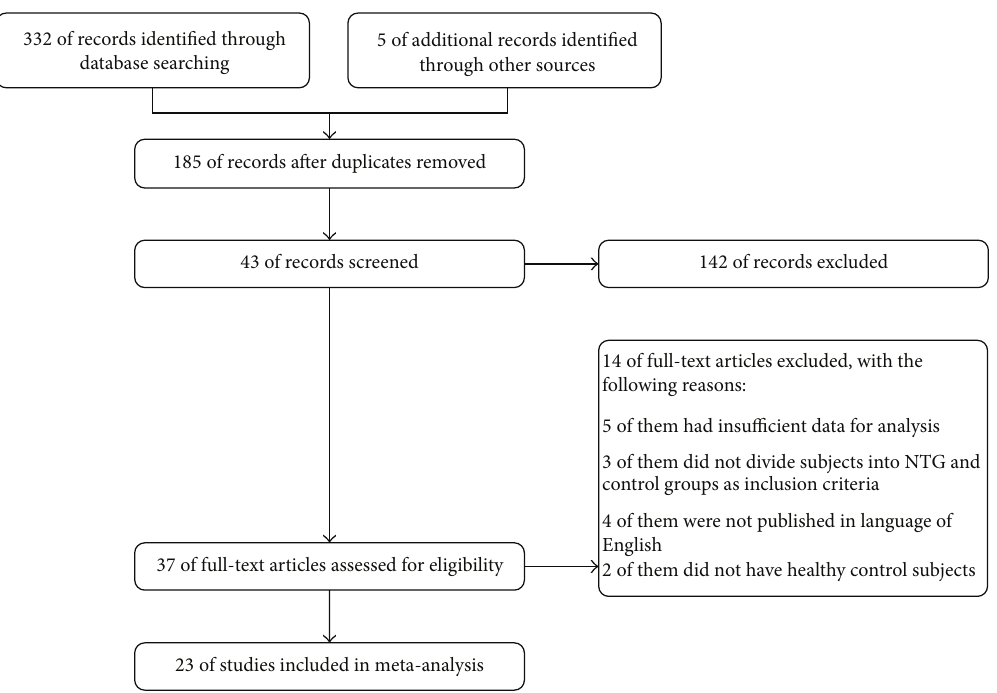
Figure 1: Flow diagram of the study selection